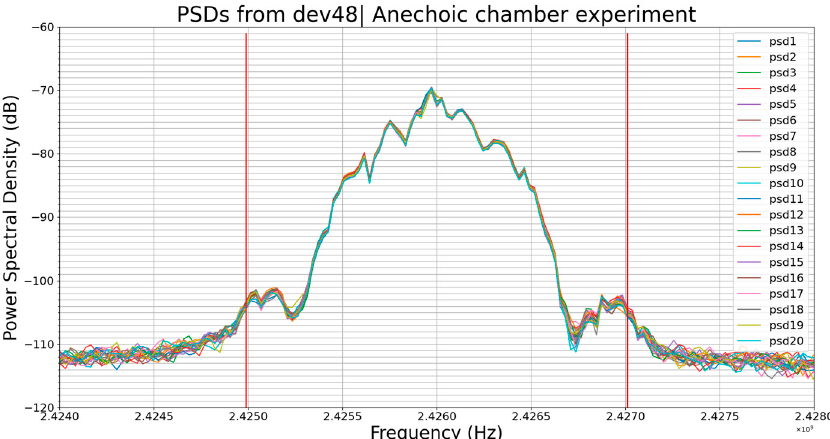
Figure 6. Twenty PSDs of a same BLE device in a static experimental setting. The region between the red lines is the band B where the PSDs are compared; we chose B = 2 MHz, which is the channel bandwidth of the BLE. So, we ignored the background noise to have a more relevant analysis.